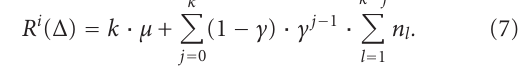
packets weights: 5 for I frame BL packets, 4 for the P frame BL packets, 3 for the B frame BL packets, 2 for the EL1 pack- ets, and 1 for the EL2 packets